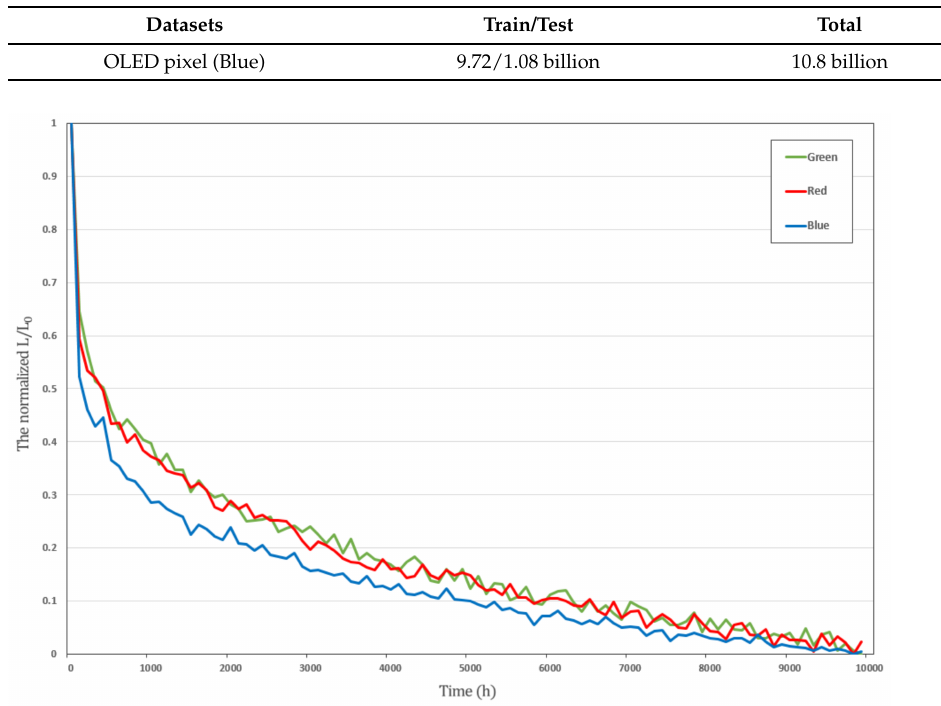
Table 3. Dataset composition.